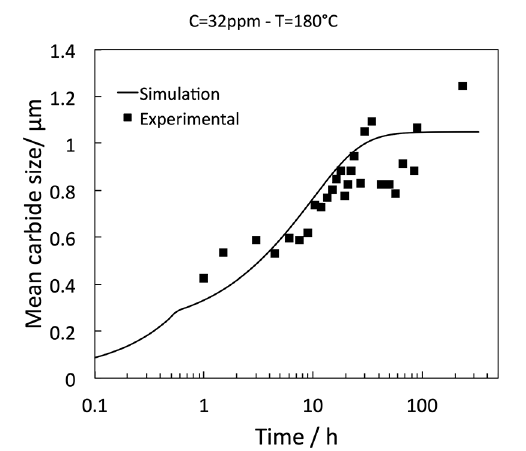
Figure 4. Fitting of experimental data of carbide mean size with time for a sample with 32ppm C and aged at 180°C.